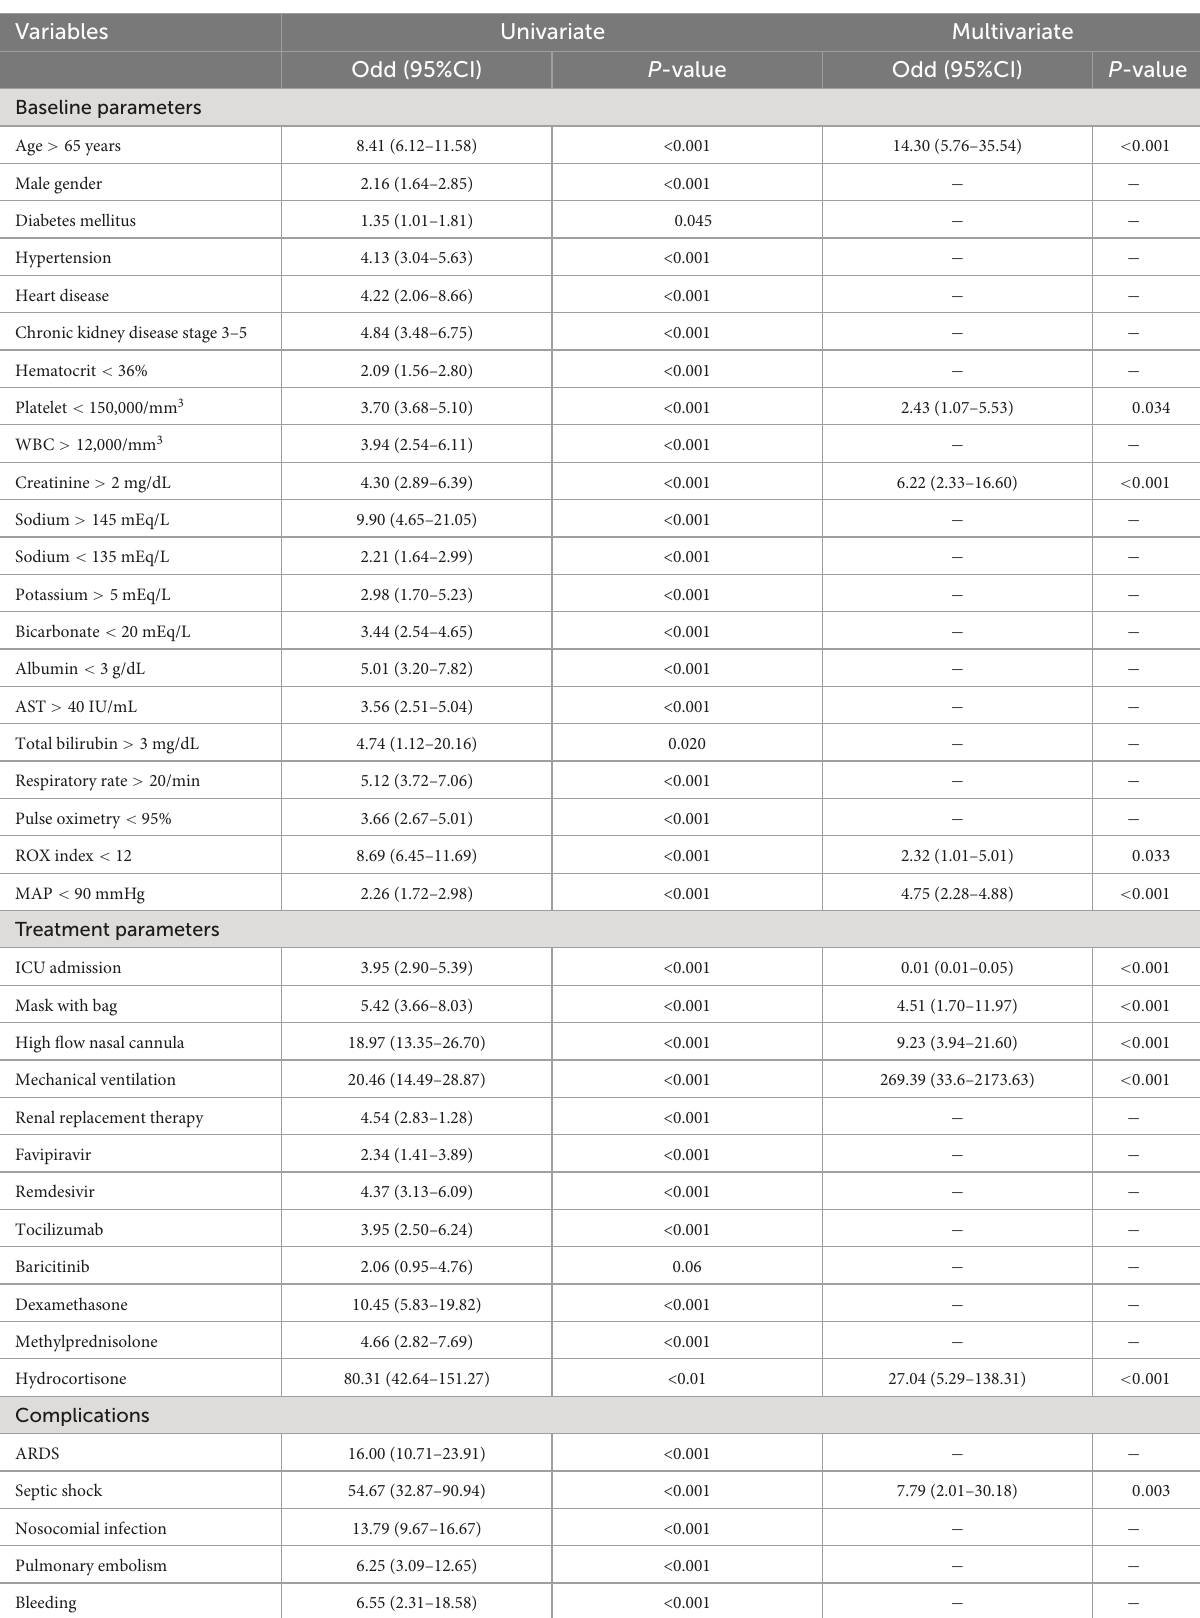
TABLE 4 Univariate and multivariate analysis to predict hospital